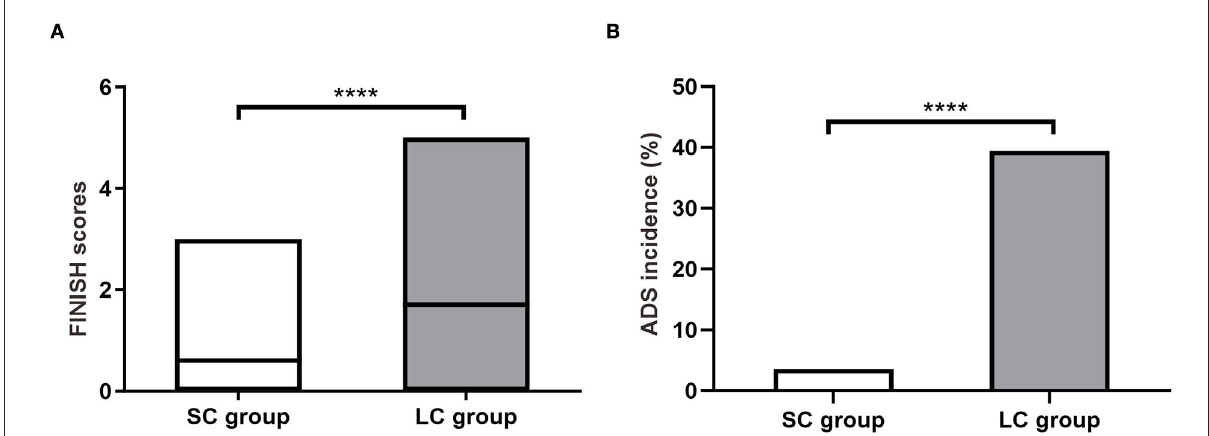
FIGURE2 Antidepressant discontinuation syndrome (ADS) in patients with refractory functional dyspepsia. (A) The FINISH scores in patients of SC group ( n = 110) and LC group ( n = 109). (B) Incidence of ADS after drug discontinuation. SC, short-course; LC, long-course. **** P < 0.0001.